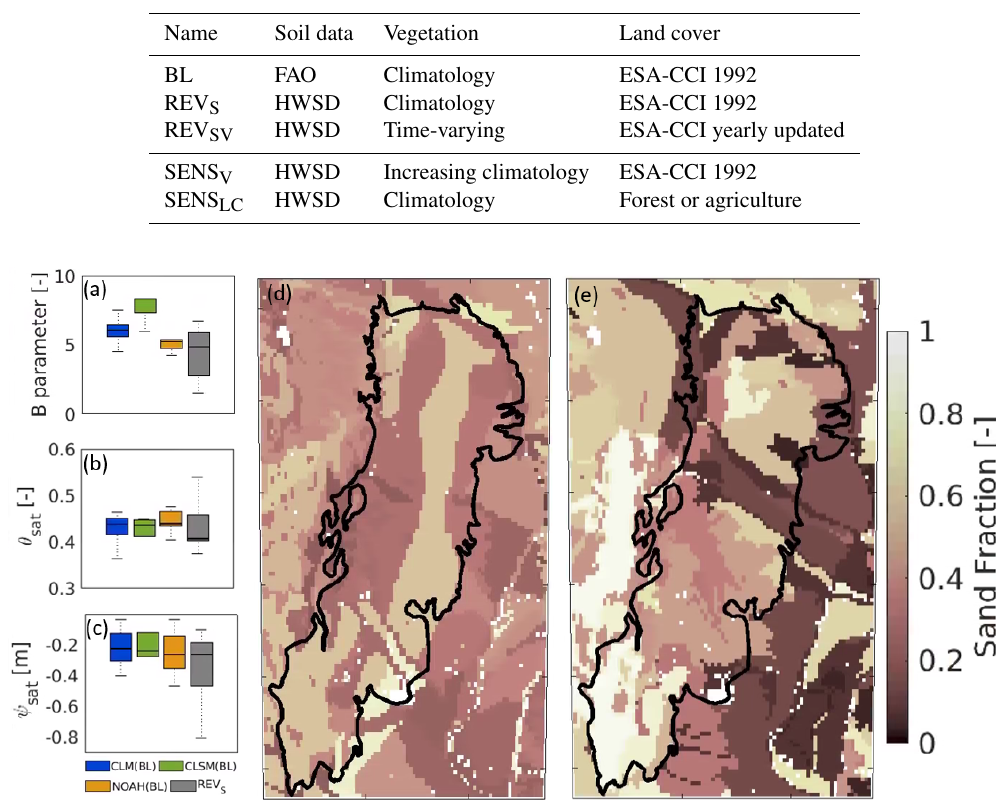
Figure 2. Spatial boxplots of soil parameters: (a) B parameter, (b) porosity θ sat and (c) saturated matric potential ψ sat used in BL and REV S simulations. Sand fraction maps associated with (d) BL (FAO surface texture) and (e) REV S and REV SV (HWSD v1.21 0–100cm